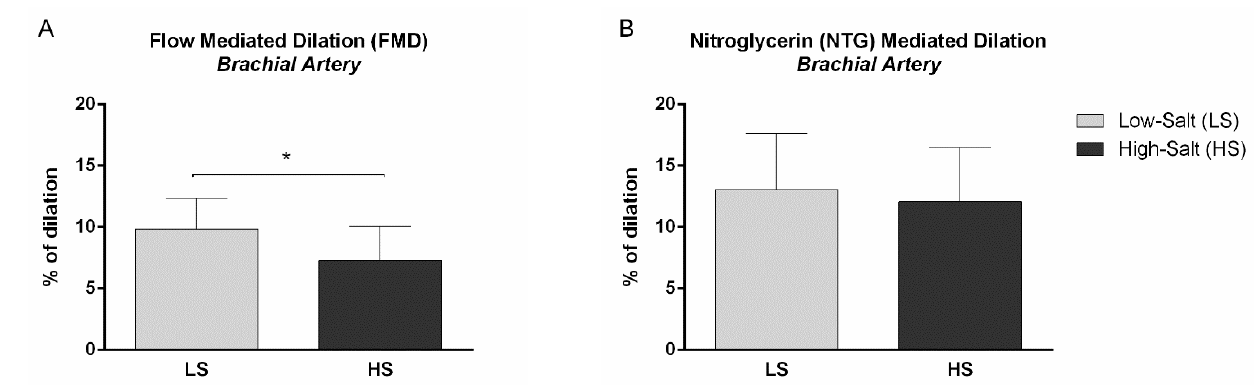
Figure 2. The effect of a 7-day high-salt (HS) diet on a macrovascular endothelial-dependent ( A ) and -independent ( B ) vasodilation in healthy individuals. ( A ) Flow-induced dilation (FMD) of brachial artery significantly decreased following 7-day HS diet, compared to LS diet condition in healthy individuals. * p < 0.001, LS vs. HS (Paired t-test). ( B ) Nitroglycerin (NTG)-mediated dilation of brachial artery remained unchanged following 7-day HS diet, compared to LS conditions in healthy individuals.